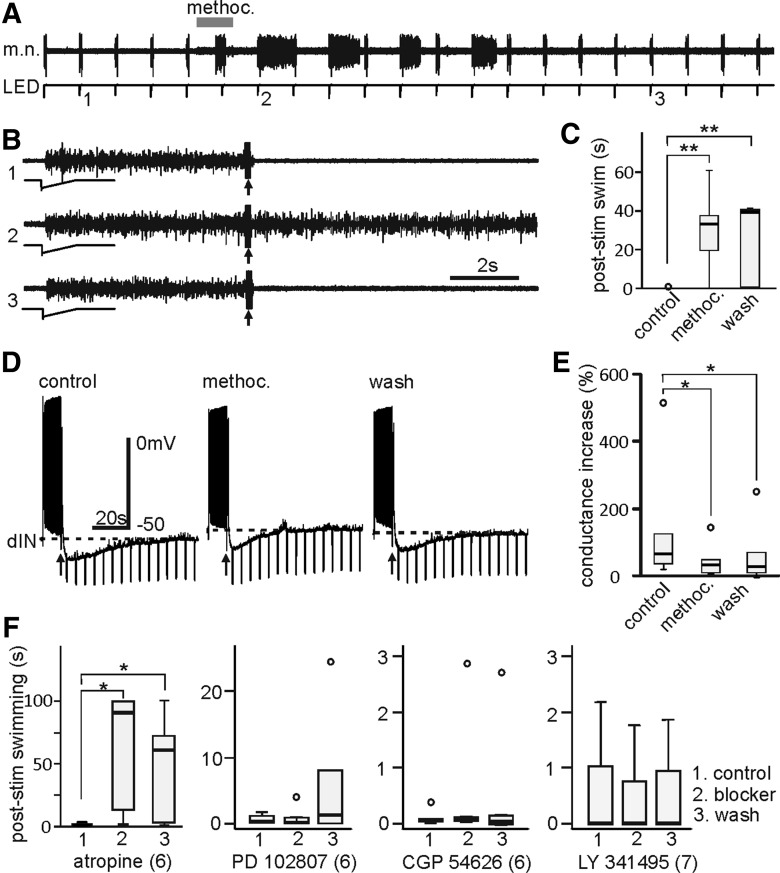
The pharmacological blockade of KO responses and KO inhibition. A, KO responses induced by KO stimulation (arrow, five pulses at 30 Hz) applied every 100 s. Swimming (m.n.) is evoked by dimming an LED. Gray bar indicates time of the application of 10 µM methoctramine (methoc., 100 s). B, Example KO responses before (1), shortly after methoc. application (2), and recovery (3). C, KO responses are blocked 200 s after methoc. application (p < 0.01, n = 9 tadpoles, related samples Wilcoxon signed rank test) but without recovery 25 min after wash. D, KO inhibition following skin stimulation (arrows, five at 30Hz) in a dIN is reduced by the microperfused 10 µM methoc. Swimming is initiated by dimming an LED light. E, Conductance increases during KO inhibition are weakened by methoc. (n = 6, p < 0.05, related samples Wilcoxon signed rank test). F, Summary of post-KO swimming lengths measured at 0, 200, and 2500 s from the application of different antagonists (numerals in brackets indicate number of tadpoles tested, related samples Wilcoxon signed rank tests). Atropine (10–50 µM) is a nonselective muscarinic receptor blocker. PD102807 (0.5 µM) is a selective M4 muscarinic receptor blocker. CGP54626 (10 µM) is a GABAB receptor blocker and LY341495 (10 nM) blocks mGluR II and III. *p < 0.05 and **p < 0.01 in C, E, F.